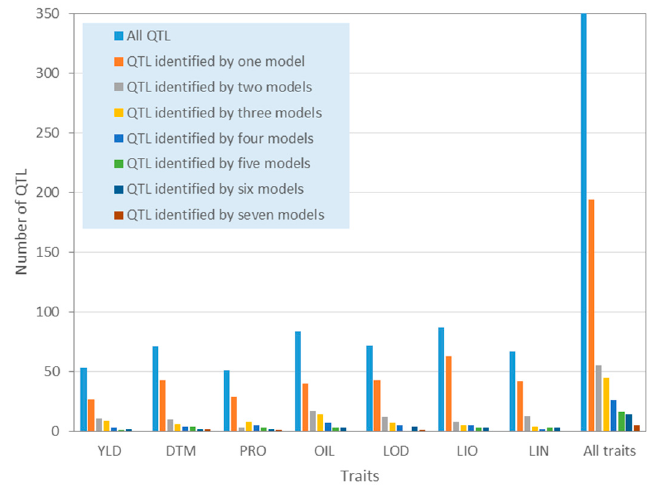
Figure 5. Histograms of quantitative trait loci (QTL) that were identified by one of the seven SNP-based multi-locus models or simultaneously by two or more models for the seven traits. YLD, seed yield; DTM, days to maturity; PRO, protein content; OIL, oil content; IOD, iodine value; LIO, linoleic acid content; LIN, linolenic acid content; SNP, single nucleotide